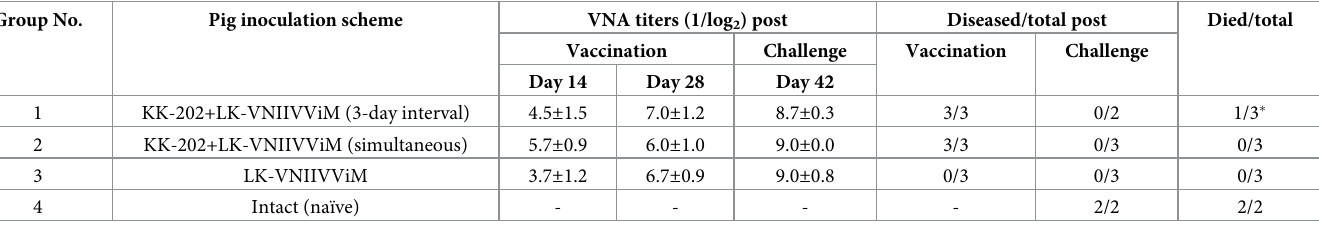
Table 2. The titers of virus-neutralizing antibodies against CSFV in pigs inoculated by attenuated ASFV (KK-202) and vaccine CSFV (LK-VNIIVViM), and results of the challenge on day 28 with the virulent CSFV strain Shimen. Group No. Pig inoculation